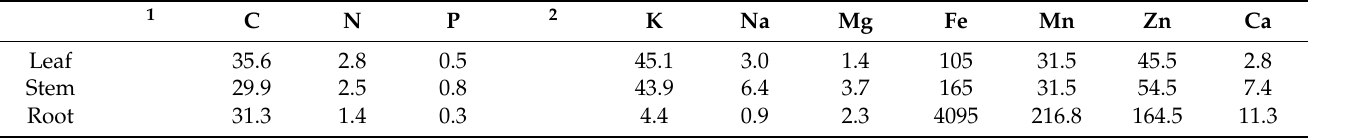
Table 1. Composition of elements in vegetative organs of L. discolor . Data are expressed per g DW. Representative values are obtained from a pooled sample (6.0 ± 1.0 g DW) of 50 individual plants ( n ≥